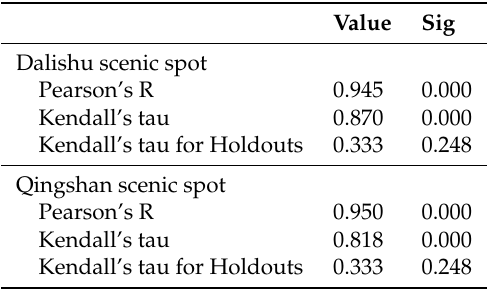
Table 4. Validity and reliability of the model.